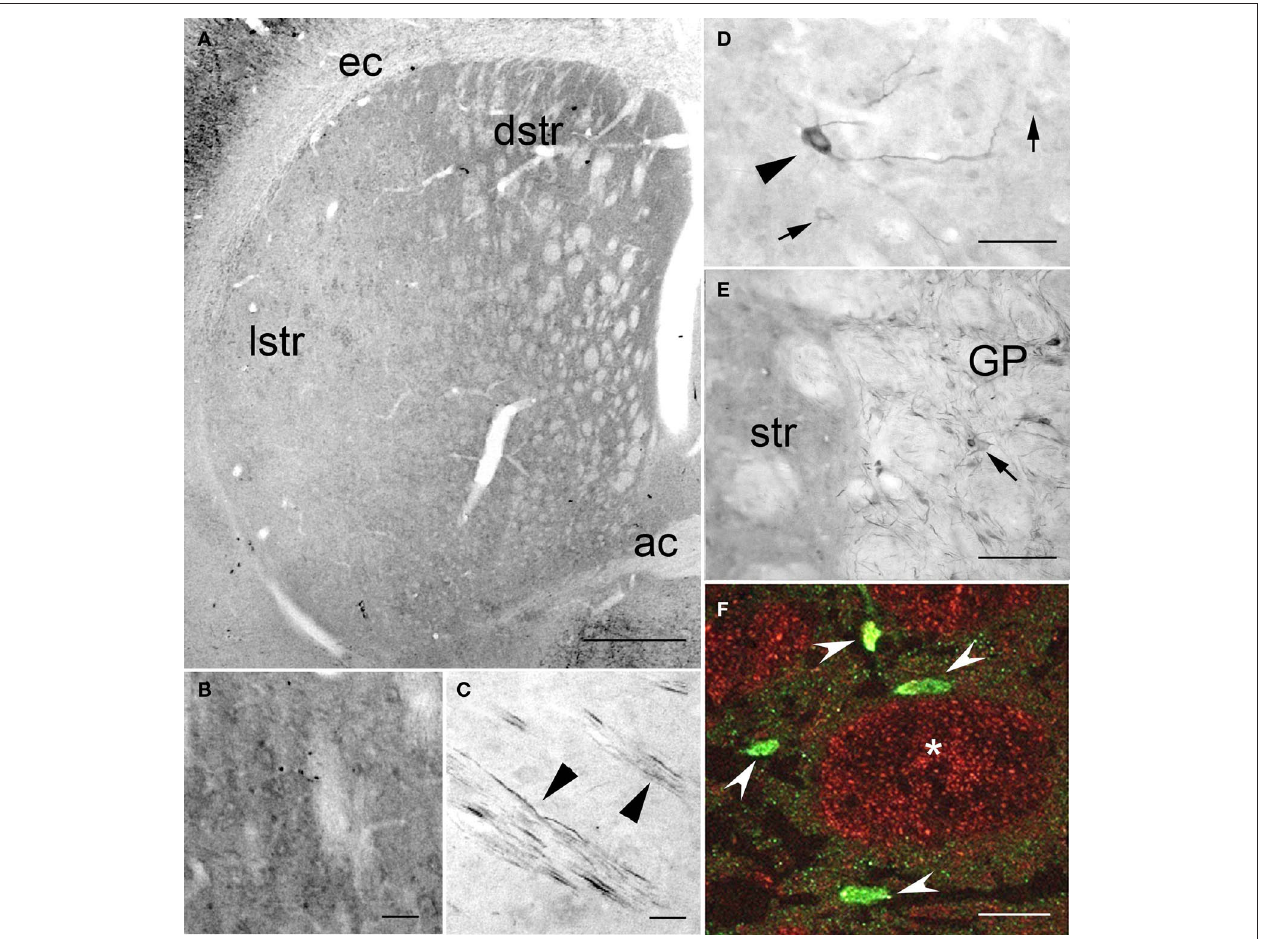
Figure 5 | PlexinA4 in the basal ganglia. (A–F) Micrographs of coronal sections through the striatum immunostained for PlexinA4. PlexinA4 immunoreactivity is highest in the neuropil in the dorsal striatum (B) and in cortico-striatal fibers in the lateral striatum (arrowheads in C ). In the ventral lateral region of the striatum PlexinA4 immunoreactive product was visible in numerous but only lightly stained medium size neurons (arrows in D ) and a few scattered large neurons (arrowhead in D ). PlexinA4 was also present in neurons